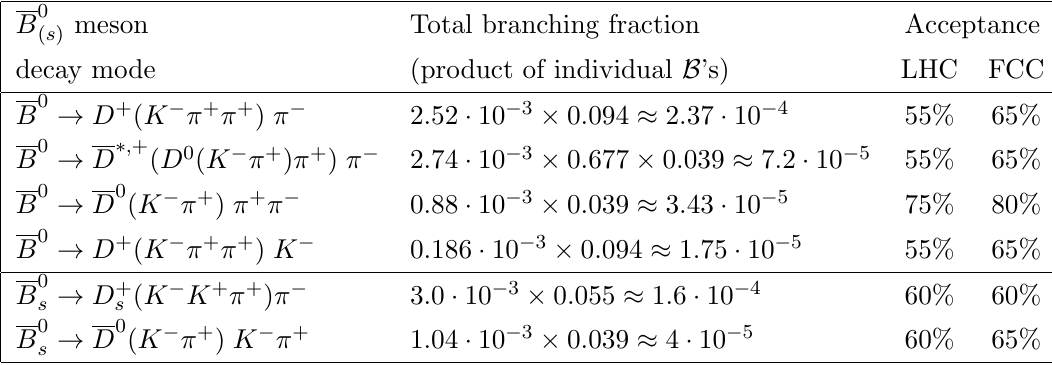
Table 8 . Most important B 0 and B 0 decay modes into D -mesons plus one (or two) light mesons, s with total branching ratios (product of each consecutive decay, from [1]), and typical acceptances for the corresponding (cid:12)nal-state decay products in the considered ( (cid:25); K ) central detector acceptances at the LHC and